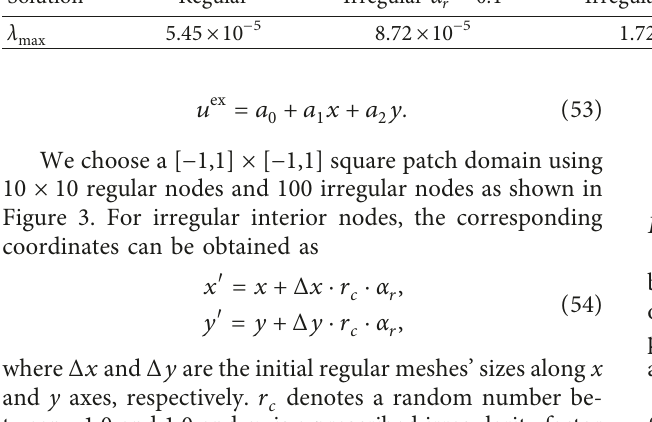
Figure 3: Regular and irregular meshes for patch test: (a) regular; (b) irregularity coefficient α irregularity coefficient α r � 0 . 3; (e) irregularity coefficient α r � 0 . 4. Table 2: Displacement error norm of numerical results for standard patch test on different meshes. Solution Regular Irregular α r � 0 . 1 Irregular, α r � 0 . 2 Irregular, α r � 0 . 3 Irregular, α r � 0 .